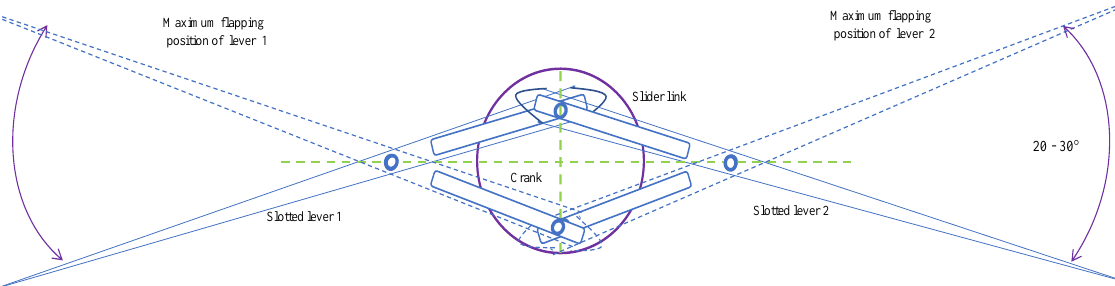
Figure 6. SC-SDL design Mechanism-II.